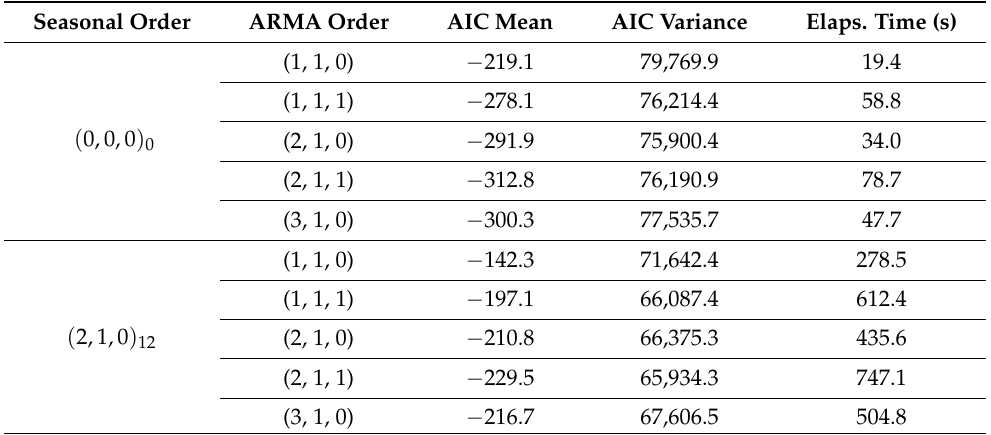
Table 2. The AIC values and the times to obtain these values for different ARIMA models. Seasonal Order ARMA